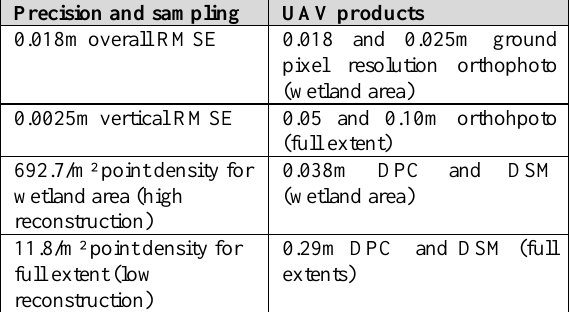
Table 2. Summary of the UAV derived products